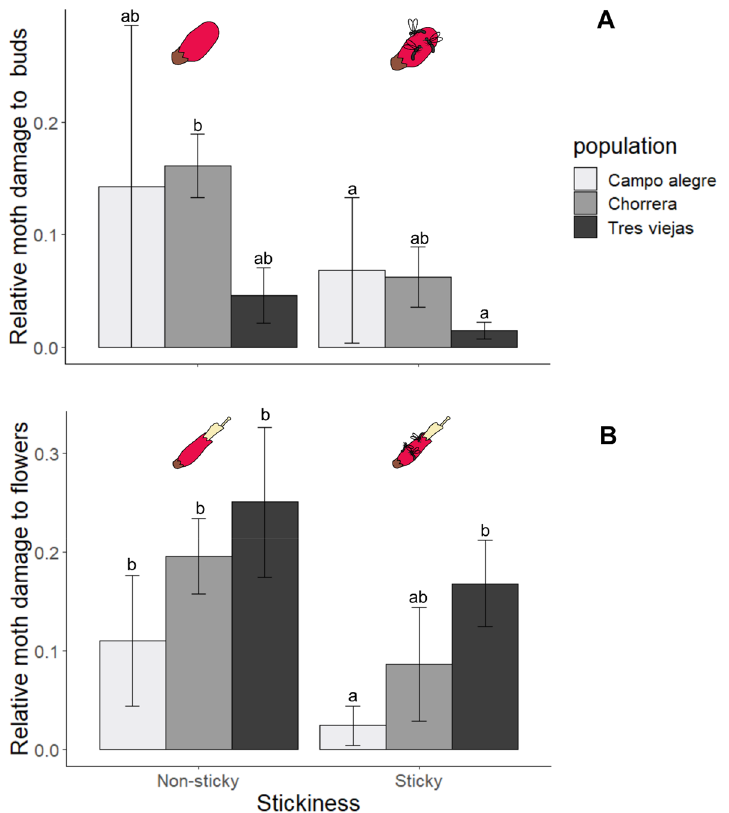
Figure 3. Relative amount of buds with damage by moth larvae (± SE) on sticky and non-sticky plants of Bejaria resinosa in three different populations. Different letters indicate significant differences (Tukey test, significance P = 0.05).